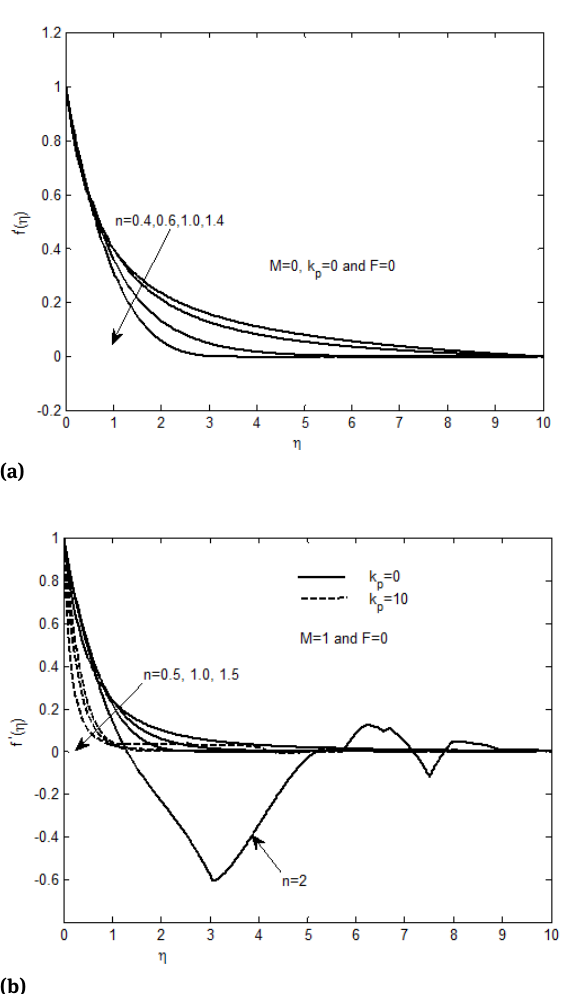
Figure 2: (a) Horizontal velocity profiles (b) Horizontal velocity